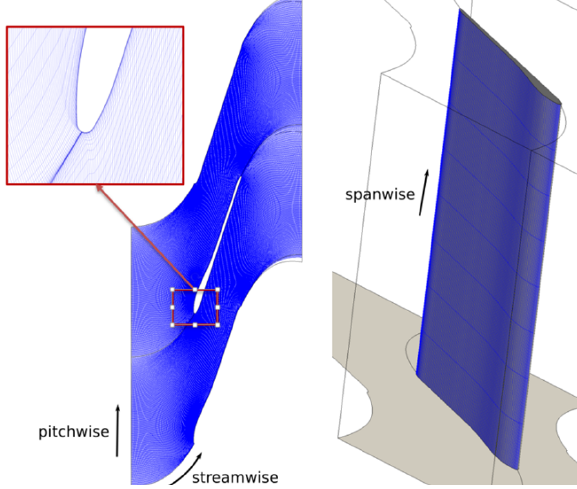
Figure 11. Details of the 3D